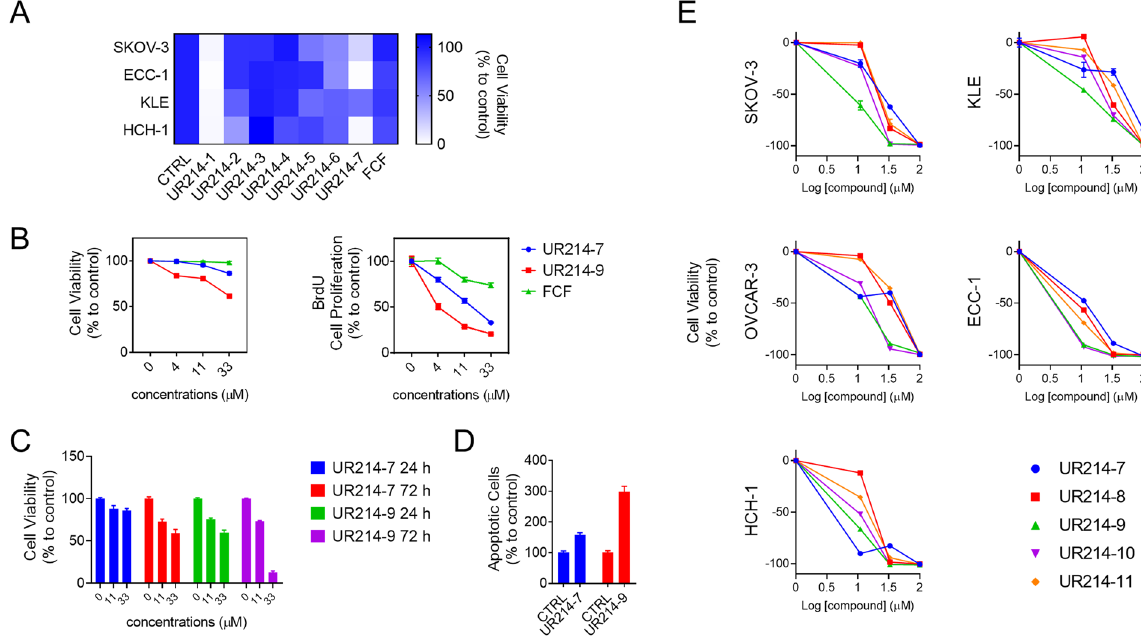
Figure 2. The effect of FCF analogs on the viability of ovarian and endometrial cancer cell lines. ( A ) Cell lines were treated with a fixed concentration (100 µ M) of FCF or FCF analog for 24 h. After treatment, cell viability was determined by MTS assay. ( N = 3, see Suppl. Fig. A for mean values and SEM) ( B ) ECC-1 cells were treated with UR214-7 or UR214-9 at the listed concentrations for 48 h. After treatment, cell viability was determined by MTS assay (left). Cell proliferation was measured by BrdU incorporation (right). ( C ) ECC-1 cells were treated with vehicle, UR214-7, or UR214-9 at the indicative concentrations for 24 or 72 h. Cell viability was determined by MTS assay. ( D ) ECC-1 cells were treated with UR214-7 or UR214-9 at 33 µ M for 48 h. Cells undergoing apoptosis were measured by caspase-3/7 activity assay ( E ) Each indicated cells were treated with various concentrations of FCF analogs for 72 h. After treatment, cell viability was determined by MTS assay.